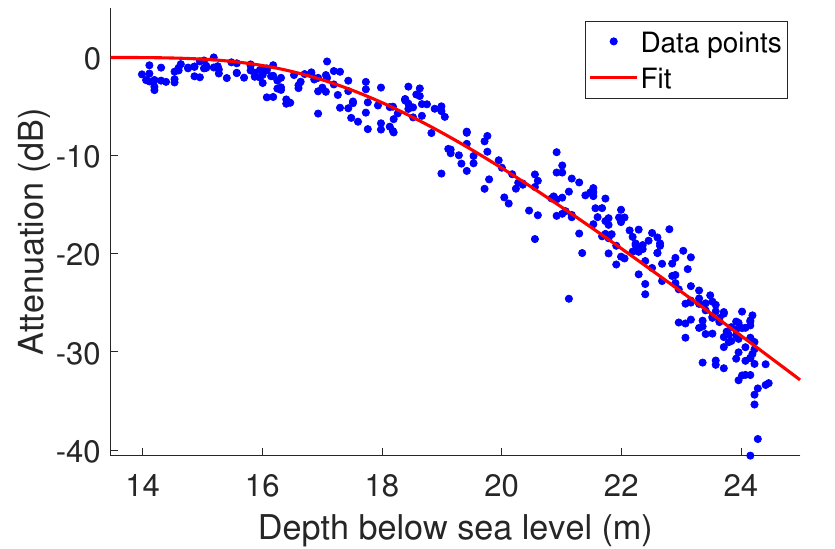
Figure 4. Attenuation of the returned signal as a function of depth. The fitted value is 4.6 ± 0.2 dB/m for the round trip, implying a value of 2.3 ± 0.1 dB/m attenuation for a single pass. The fit’s correlation coefficient is R =